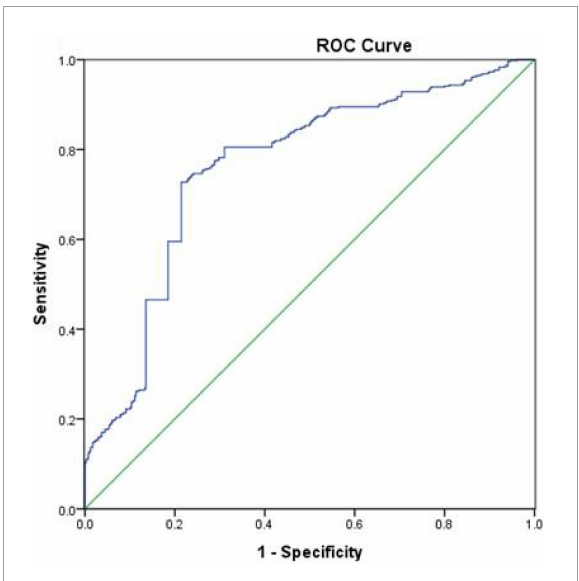
26.92, P = 0.249) or TNM stage (197.74 ± 27.46 vs. 202.62 ± 26.87 vs. 200.4 ± 30.24, P = 0.404).